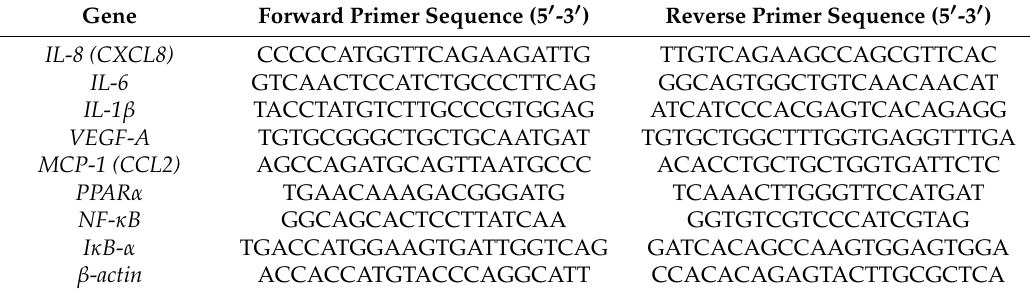
Table 1. Primers used for real-time